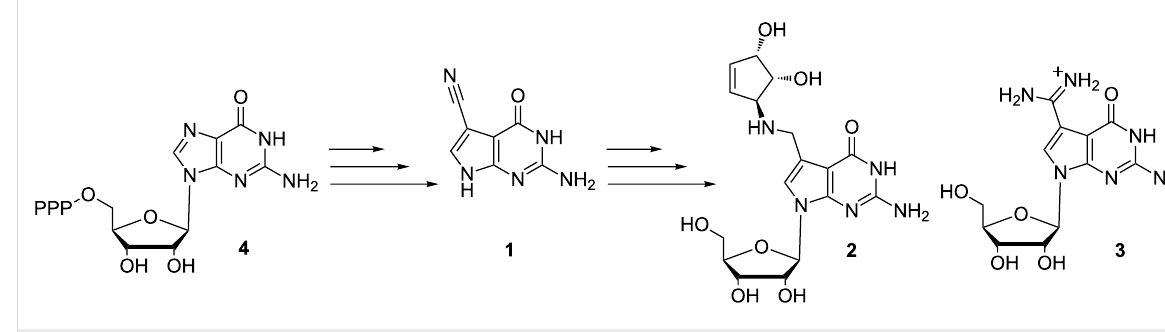
Figure 1: Biosynthetic pathway leading to nucleosides queuosine and archaeosine.